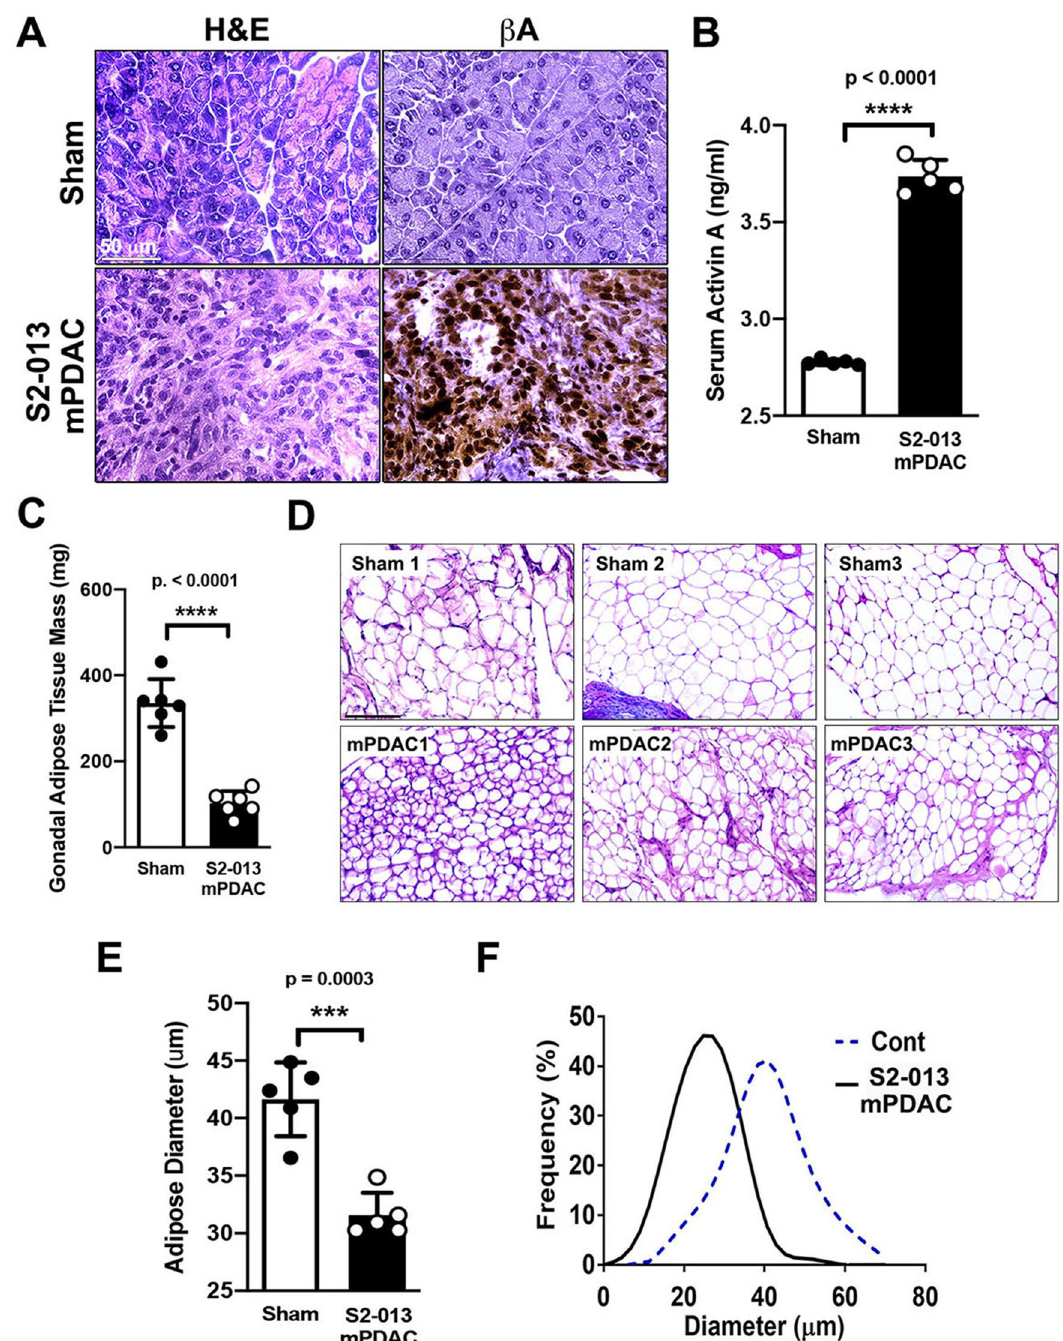
Figure 5. Activin A can be correlated with loss of gonadal visceral adipose tissue in an orthotopic implantation model of PDAC. ( A ) Representative immunohistochemical images of activin A expression in healthy control C57BL/6 J pancreatic tissue and tumor specimens of S2-013 mPDAC. Scale bar = 50 µm. ( B ) Measurement of serum activin A levels in sham and S2-013 mPDAC. ( C ) Mass of gonadal fat pad. ( D ) H&E images of adipose tissue from the gonadal fat pad in sham and S2-013 mPDAC. Scale bar = 150 µm. ( E ) Measurement of adipocyte diameter in gonadal adipose tissue from sham and S2-013 mPDAC. The diameters of adipocytes were measured from several histological sections ( n = 5 ). The average adipocyte diameter from each animal was marked with a dot. F. Frequency curve of adipocyte diameter in gonadal fat pad of sham mice (dashed line) and S2-013 mPDAC (solid